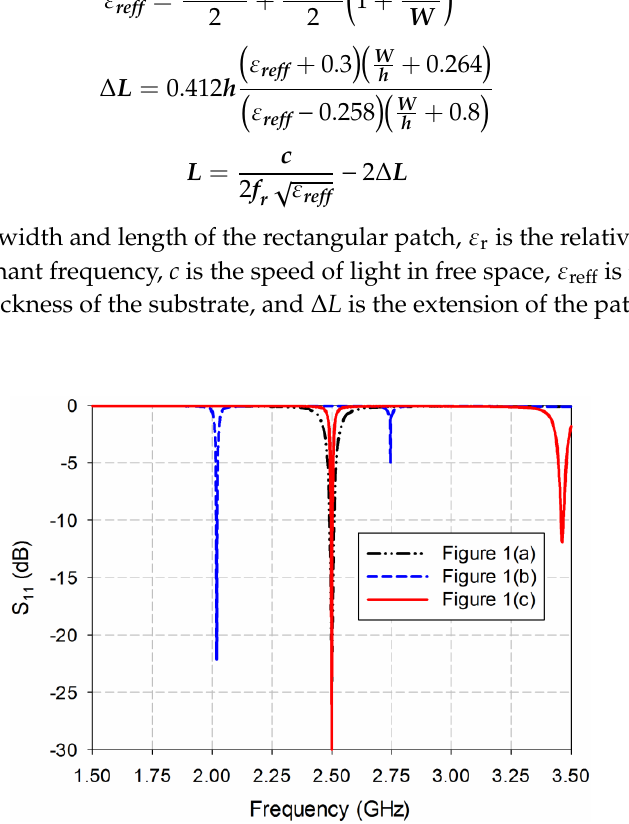
Figure 2. Input reflection coefficient characteristics (S 11 ) of the three antennas in Figure 1.